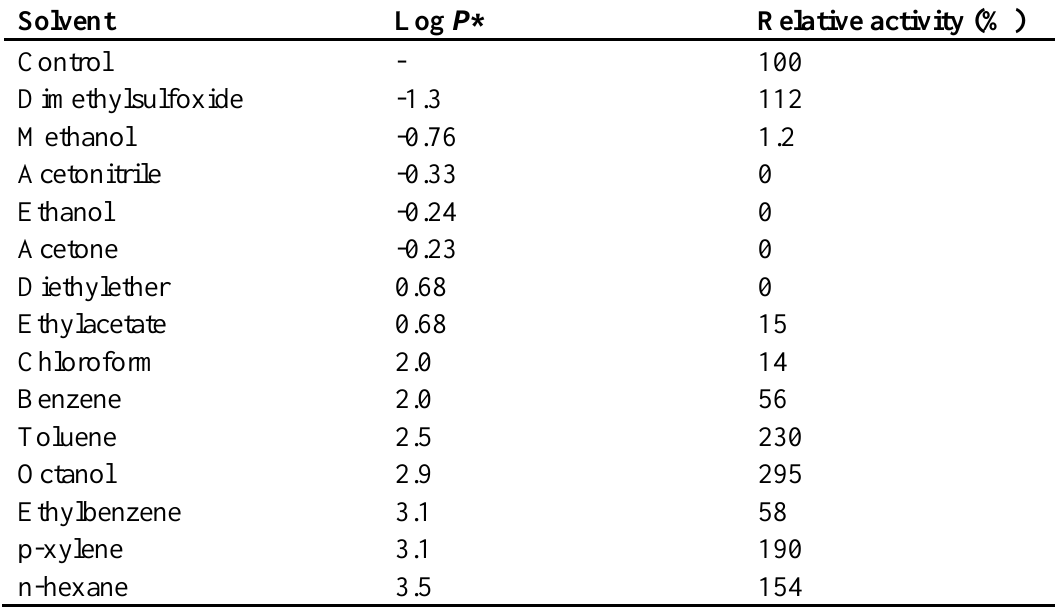
Table 1. Effect of various organic solvents on AT2 lipase